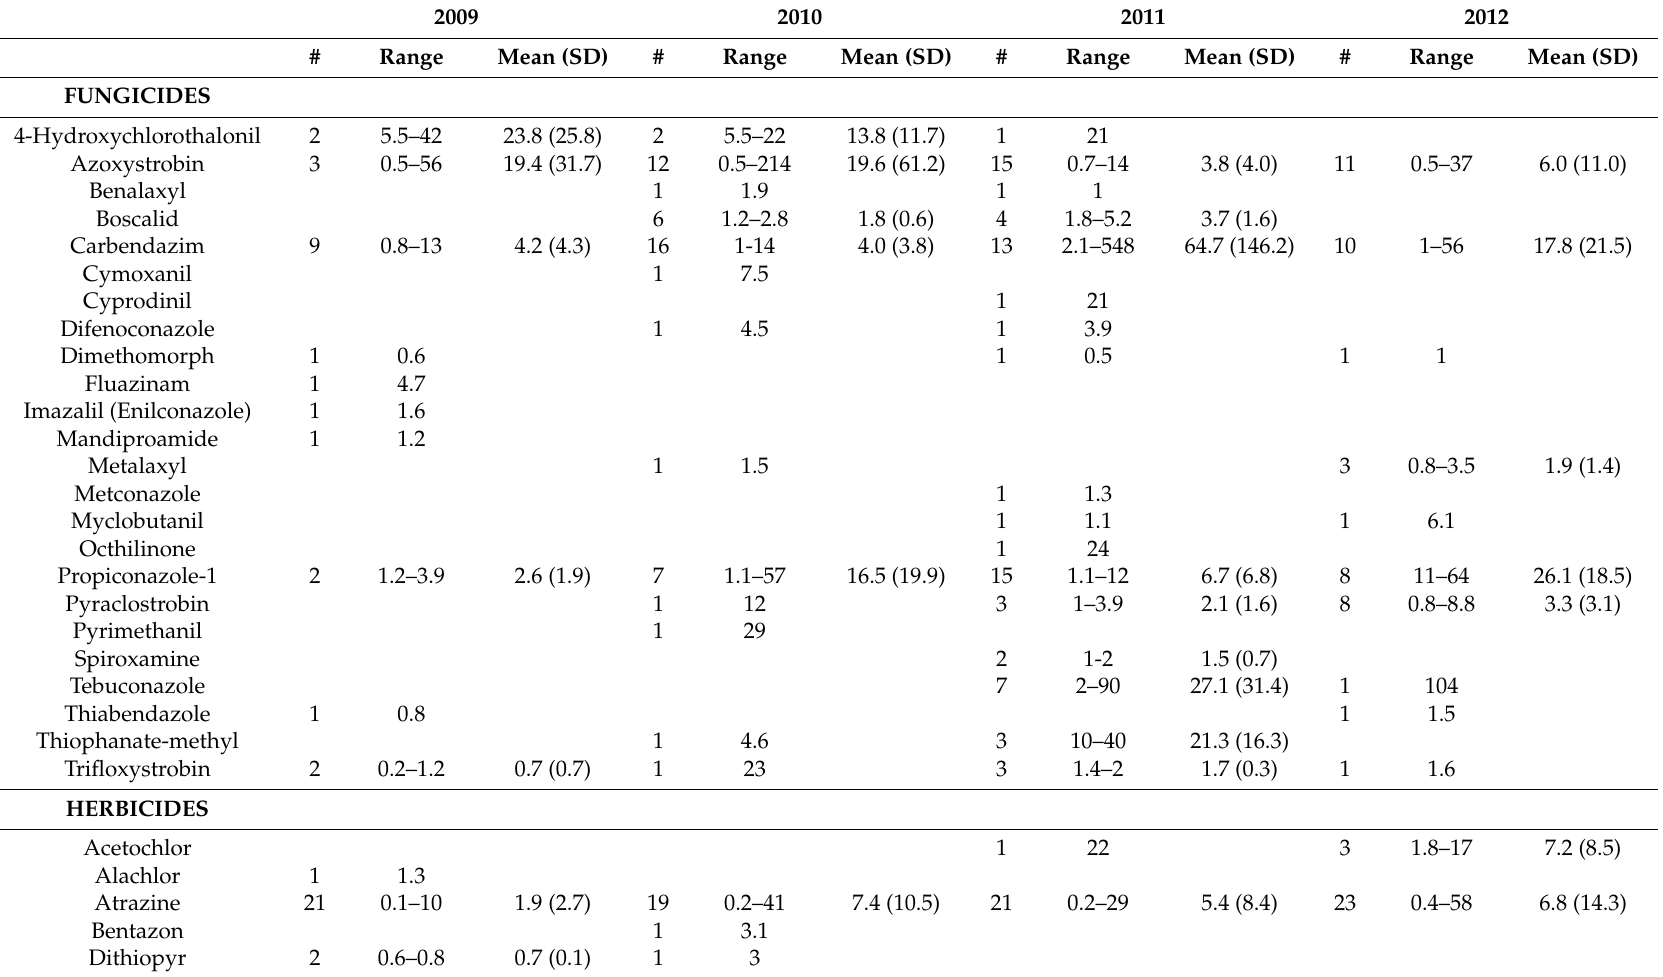
Table 3. Pesticide detections in pollen by year and pesticide: number of detections (#), and the range and mean (standard deviation (SD)) of the amount detected (in ppb). See Section 3.1, 3.3–3.5 for a summary